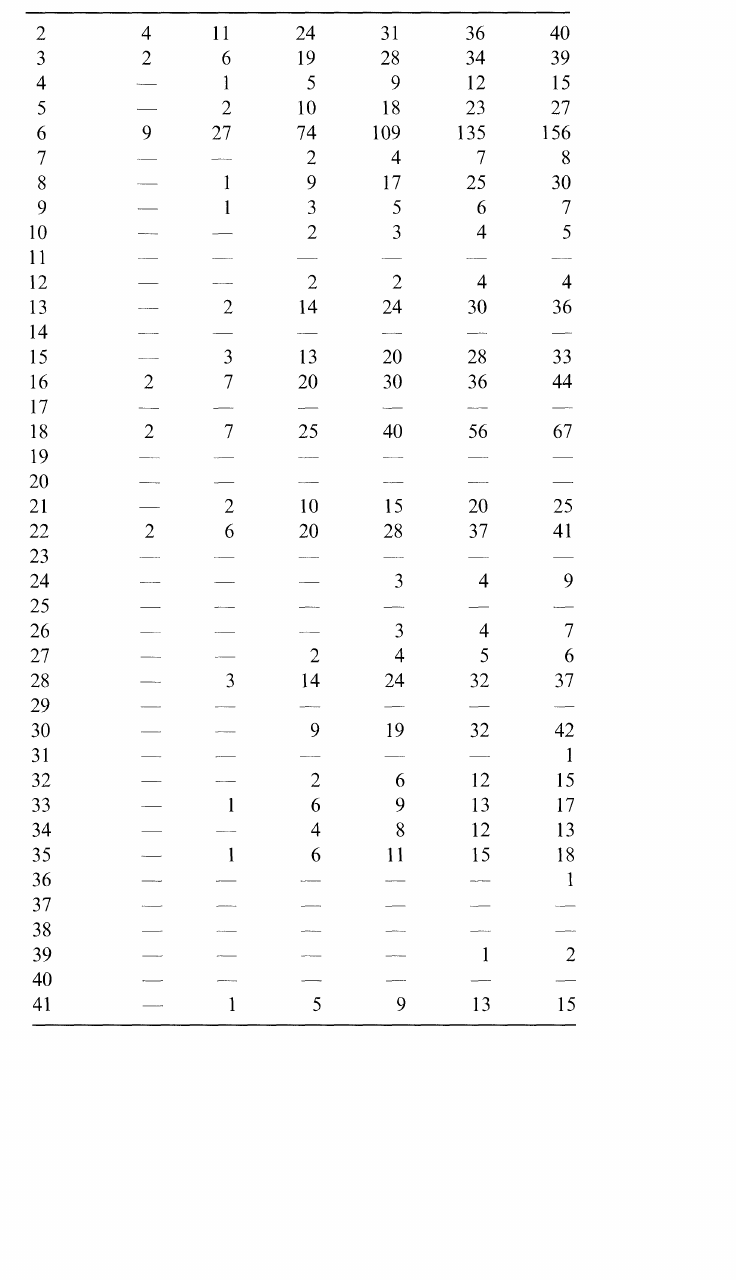
Cumulative frequencies of periodic cycles in unit’s fractions decimal streams